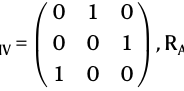
Fig. 5 | Asymmetric encryption scheme. a Rotation transformation of the Poin- caré sphere corresponding to the transformation of eigenstates from originally circular polarizations to an arbitrary eigenstate pair | α 〉 and | β 〉 . Inset (upper): The secret images are encrypted in azimuth and elliptical angles. Inset (bottom): Transformation of eigenstates. b Measured ciphertexts and Stokes vectors ( S m1 ,